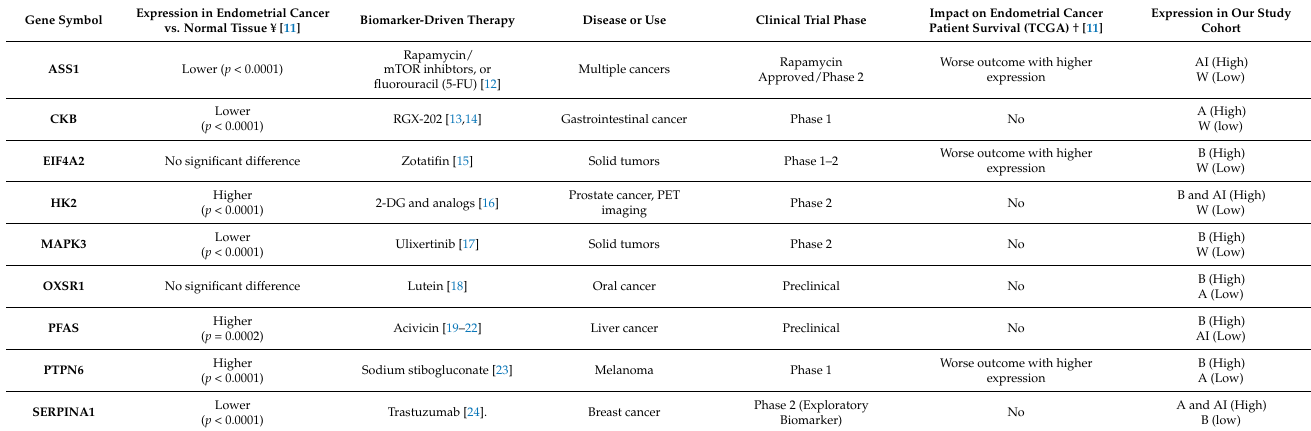
Table 3. Targetable differential proteins that have reported survival and prognostic